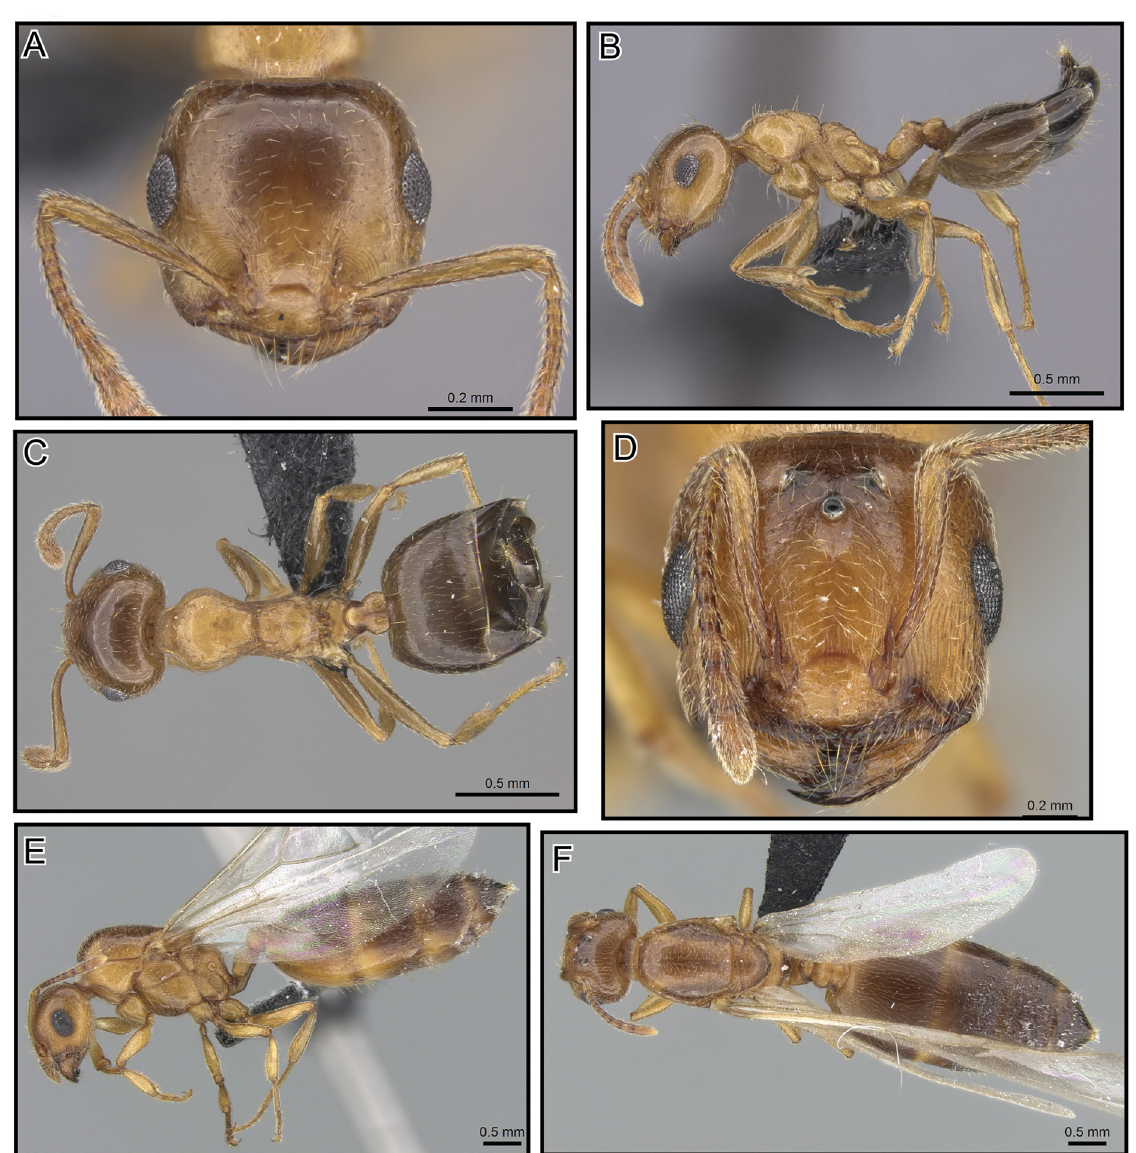
Fig. 20. Crematogaster sewellii Forel, 1891, worker and queen. A-C. Worker (CASENT0120975). A. Full-face. B. Profile. C. Dorsal. D-F. Queen (CASENT0496779). D. Full-face. E. Profile. F.